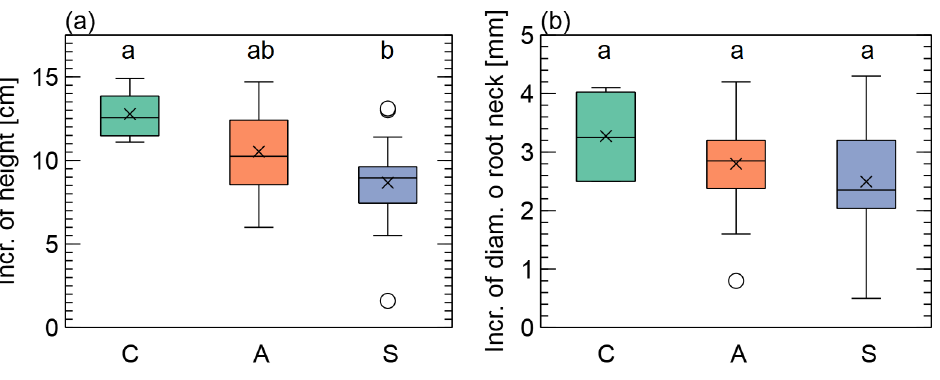
Figure 3. Increase in seedling length ( a ) and root collar diameter ( b ), calculated as the difference between measurements in October and April. Three types of treatments are presented: soil amend- ments with phosphogypsum mixed with organic ash—A, sewage sludge—S and control—C. The lowercase Latin characters above box plots, if the same, indicate that there is no statistically significant difference between the groups at p < 0.05. In the plot, boxes span from 1st to 3rd quantile, with the median indicated by a line, whiskers indicating 1.5 inter-quantile range, the × symbol mean value, and circles outlier